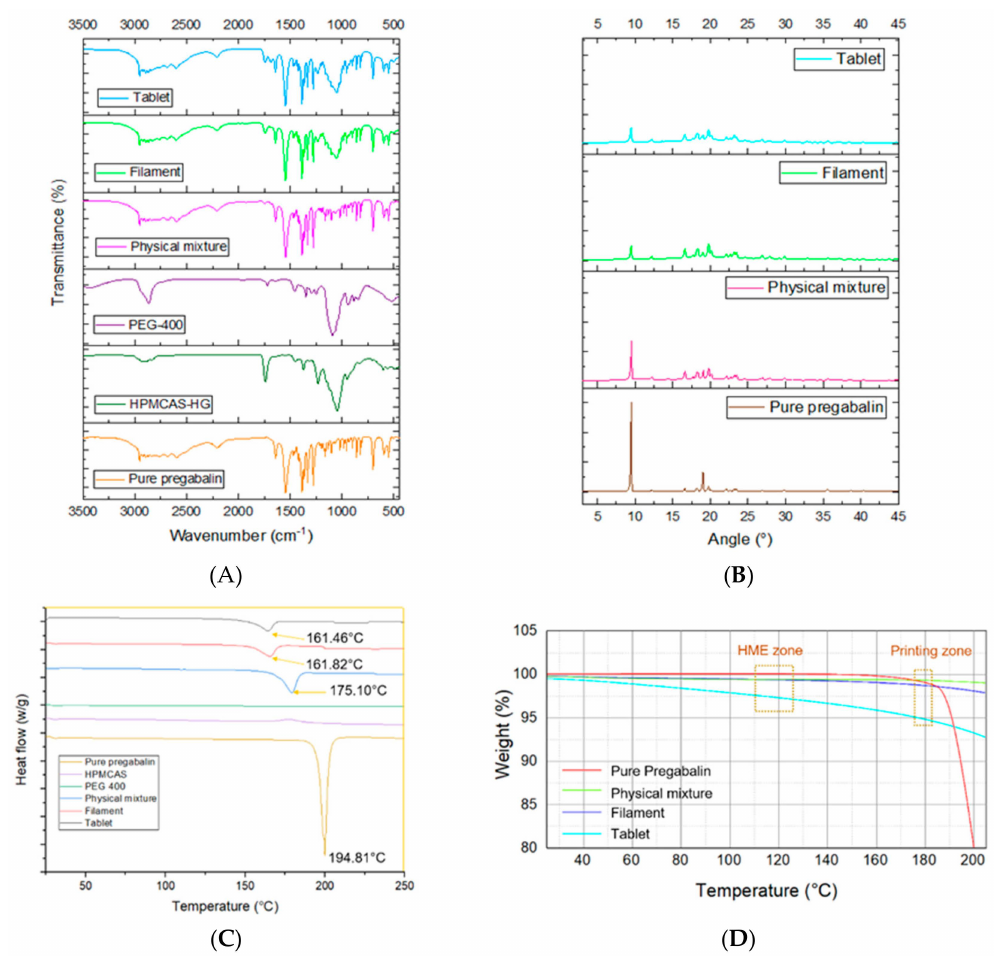
Figure3. Physicalcharacterizationof printedtablets. Fourier-transforminfraredspectroscopy( A ),X-ray powder di ff ractometry ( B ), di ff erential scanning calorimetry ( C ), and thermogravimetric analysis ( D ).